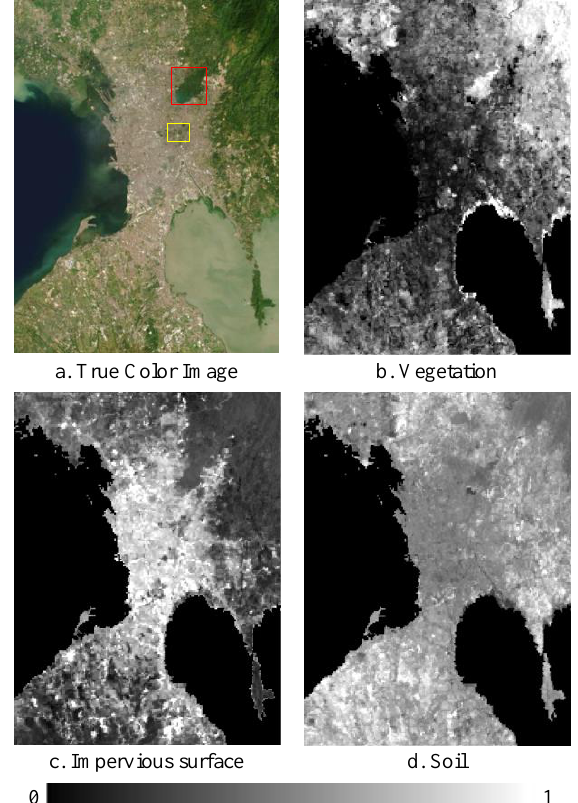
Figure 6. True-color image of the study area showing La Mesa Ecopark (red box) and UP Diliman (yellow box) (a). Resulting fraction images of vegetation (b), impervious (c), and soil (d) from Linear Spectral Unmixing of Sentinel-3 Image. Dark color represents higher abundance while bright color represents lower abundance